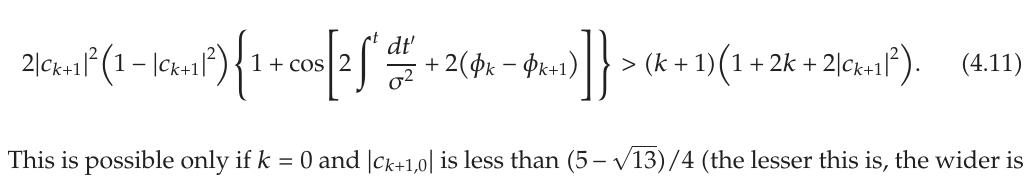
Figure 9: Wigner functions of (cid:4) 1 /